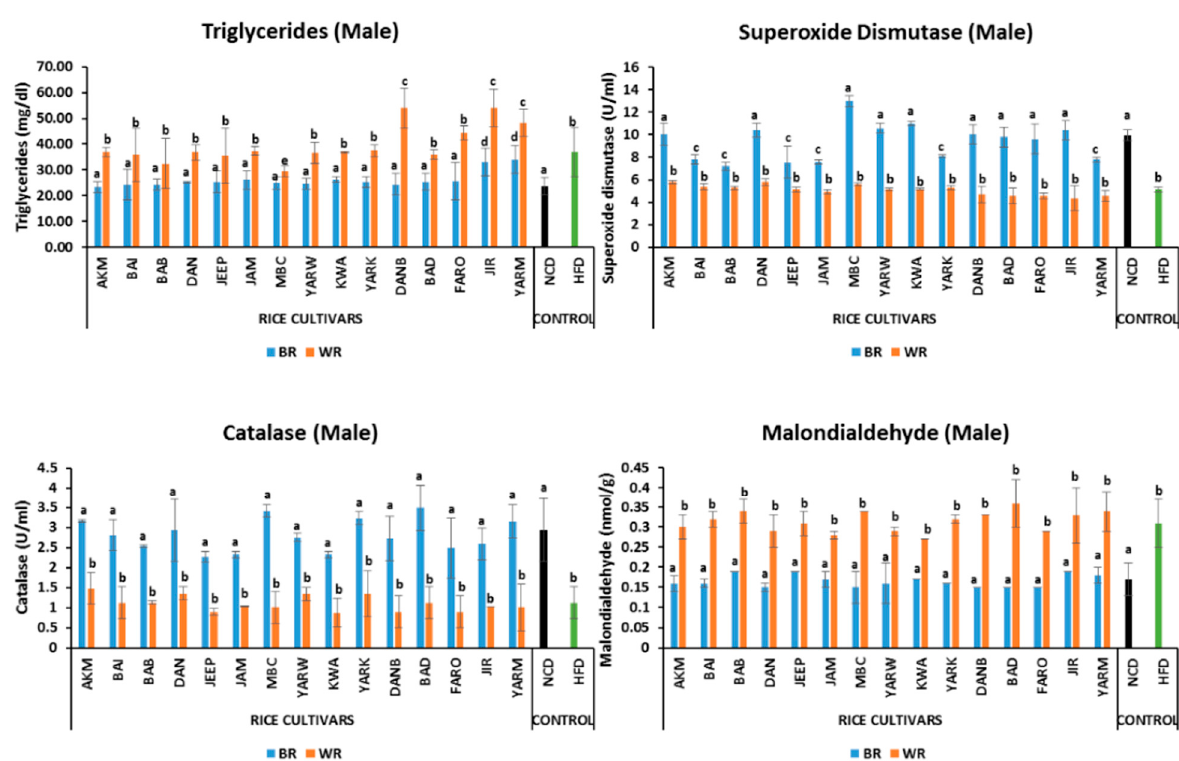
Figure 3. Effects of rice cultivars on triglyceride level and oxidative stress markers in male flies after 7 days of intervention. Bars represent mean ± SD. Bars denoted by the same letters are not signifi ‐ cantly different ( p ˃ 0.05). (n = 30). Black and green bars represent the groups fed normal diet and high fat ‐ diet respectively. NCD = normal diet, HFD = high ‐ fat diet, Akai maza hajj = AKM, Baingila = BAI , Baburashi = BAB, Jamila = JAM, Maibakincarki = MBC, Yarwasagi = YARW, Kwandala = KWA, Yarkatabore = YARK, Danboto = DANB, Bakindanboto = BAD, Faro 44 = FARO, Jirkita = JIR, Yarkukuma = YARM, Dankaushi = DAN, Jeep = JEEP.